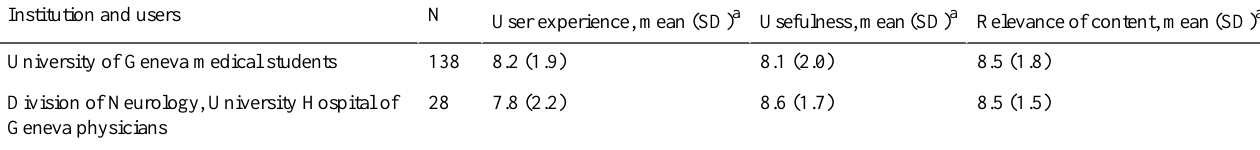
Table 3. Pre- and postgraduate assessment of